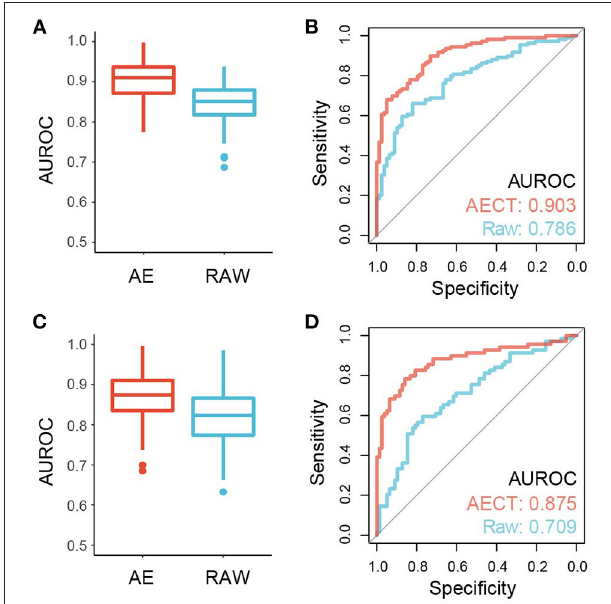
FIGURE 6 | Performance of cancer detection using AECT-imputed data. (A) Median AUROC of 100-times permutation with 5-fold cross validation on a training cohort of breast cancer datasets ( p = 4.62 × 10 − 13 , Wilcoxon rank sum test). (B) ROC curve of validation cohort of breast cancer datasets ( p = 7.36 × 10 − 4 , Delong test). (C) Median AUROC of 100-times permutation with 5-fold cross validation on a training cohort of rectal cancer datasets ( p = 3.35 × 10 − 8 , Wilcoxon rank sum test). (D) ROC curve of validation cohort of rectal cancer datasets ( p = 1.78 × 10 − 3 , Delong